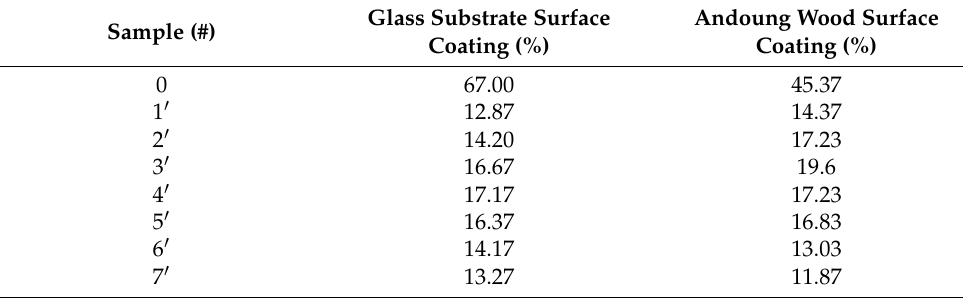
Table 7. The gloss of coating with different microcapsule